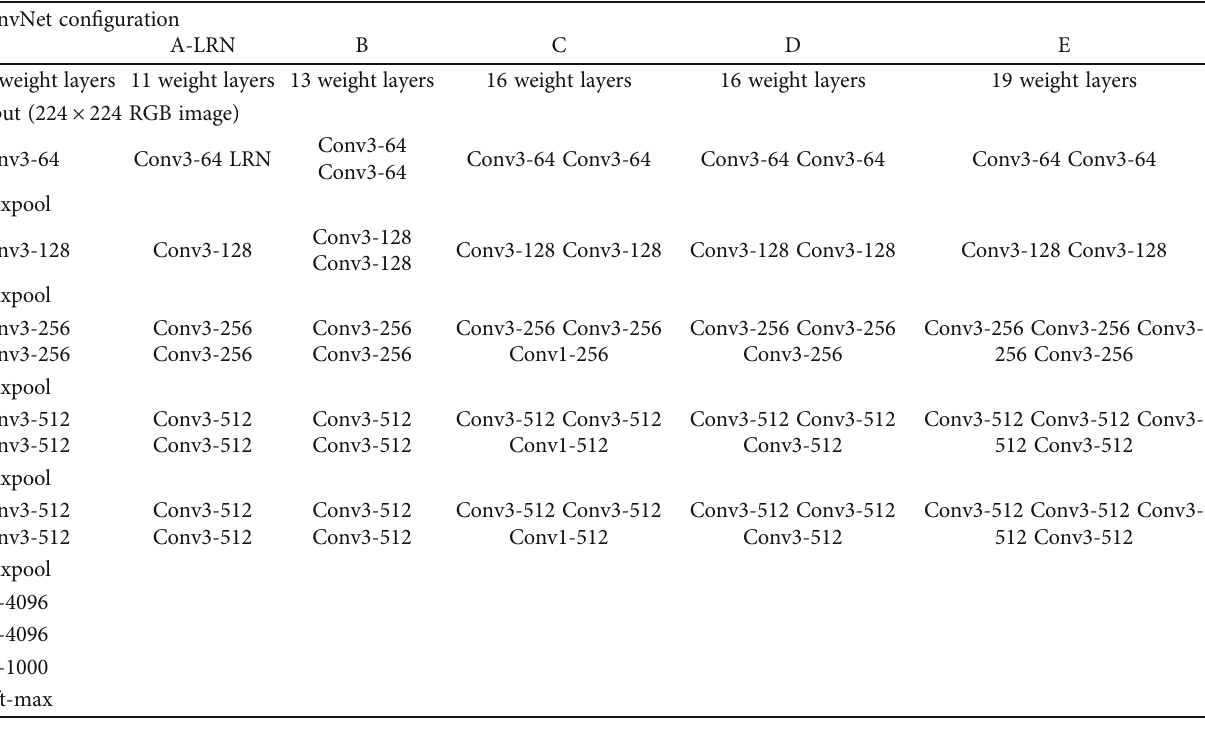
Table 5: Network structures of VGG.